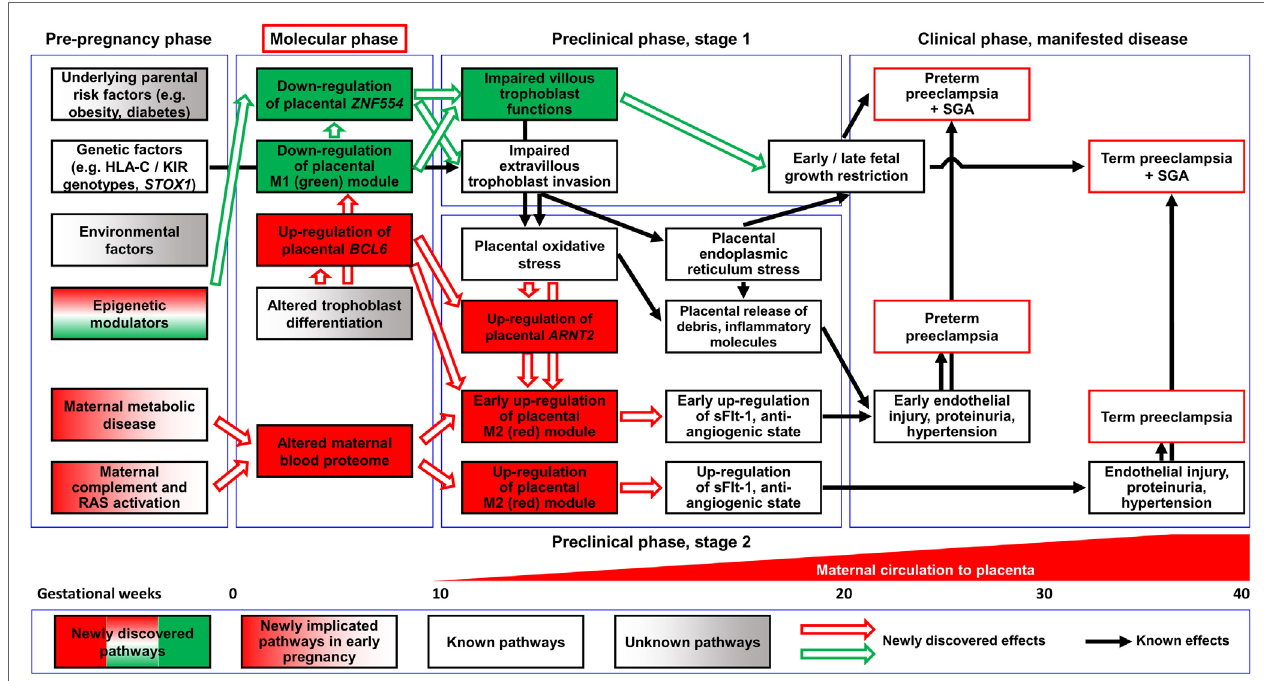
FigUre 12 | Pathologic pathways in preeclampsia. Maternal pathways: alterations in the maternal blood proteome, including systemic inflammatory changes, can be observed in both preterm and term preeclampsia before the maternal circulation of the placenta has been established, supporting the observation that maternal factors have a key role in triggering early disease pathways. Later, these alterations can induce trophoblastic functional changes leading to the up-regulation of module M2 genes, the overproduction of sFlt-1, and an anti-angiogenic state through a trajectory that does not necessarily affect fetal growth. Placental pathways: altered differentiation of the trophoblast leads to the dysregulation of module M1 genes and hub factors in module M2. The down-regulation of ZNF554 and module M1 genes involved in the regulation of fetal growth and metabolism imply impaired villous trophoblast (VT) functions besides abnormal extravillous trophoblast (EVT) invasion. The up-regulation of the BCL6-ARNT2 pathway sensitizes the trophoblast to ischemia and increases FLT1 expression after the maternal circulation to the placenta has been established. These changes are observed only in preterm preeclampsia, suggesting that this placental pathway promotes the early development of preeclampsia. The interplay of these molecular pathways leads to the complex pathogenesis of preeclampsia. Abbreviations: RAS, renin-angiotensin system; SGA, small-for-gestational